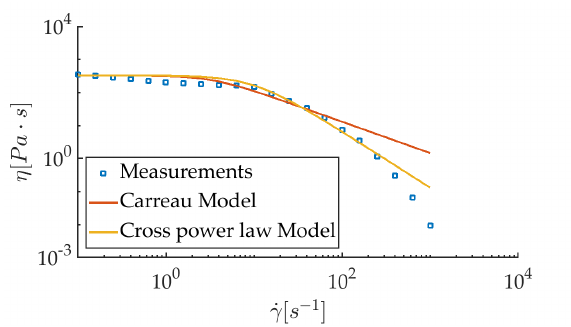
Figure 3. Dynamic apparent viscosity of the poly(lactic acid) (PLA) used for experiments.